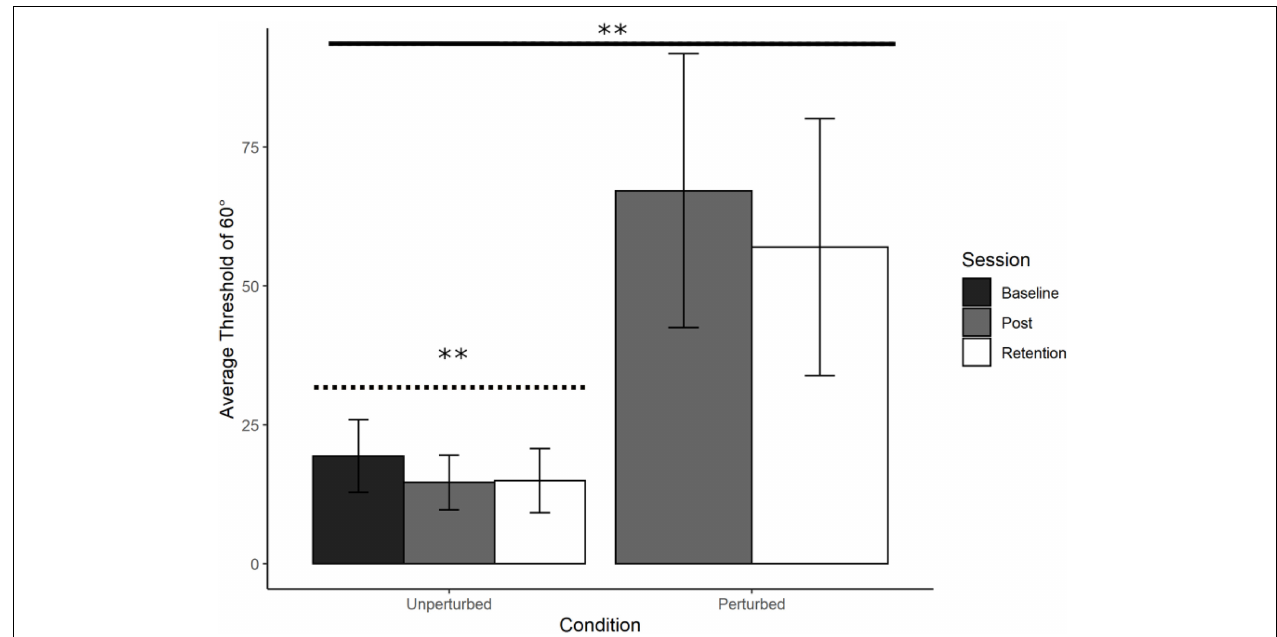
FIGURE 5 | Young adults trained at 60 ◦ : Average perceptual judgement thresholds. Average perceptual judgement thresholds for 60 ◦ with standard error bars at Baseline, Post training and Retention. Significance levels are indicated on the figure ( ∗∗ p < 0.01). There was a significant main effect of Condition, with the perturbation reducing performance (solid line). The contrast analysis demonstrated that the learning data was a good fit for the unperturbed judgement data (dotted